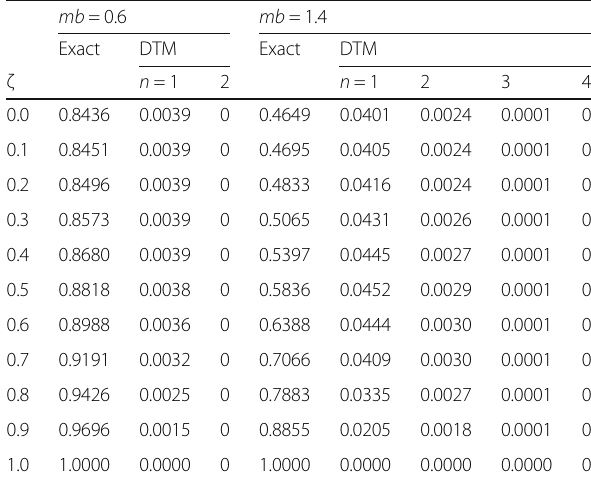
Table 2 Comparison of the DTM and exact results for different approximations